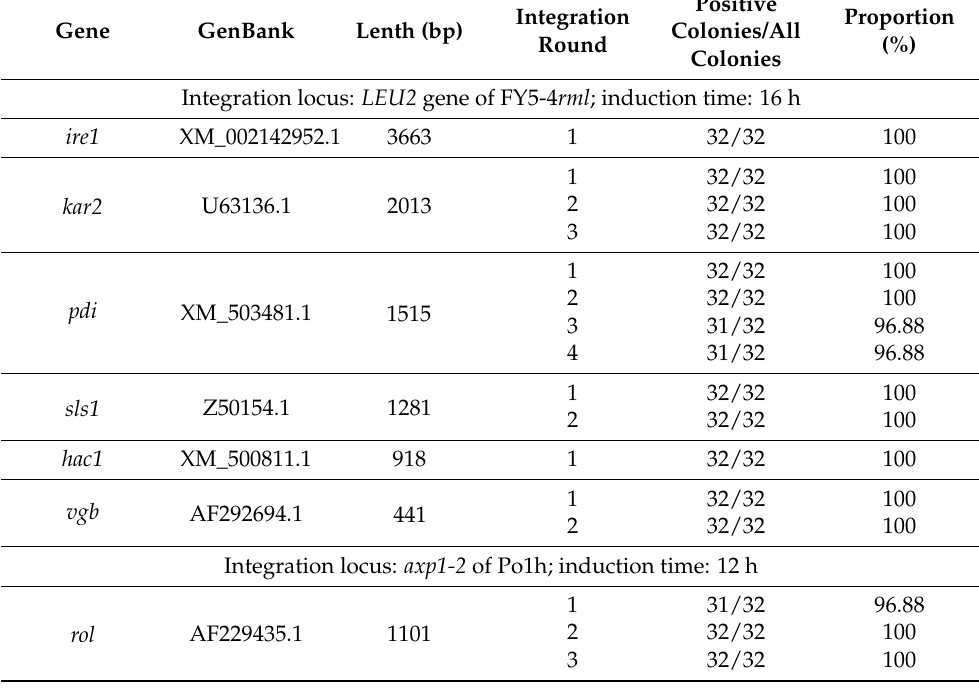
Table 2. Integration rates of various genes, loci and strains in this study.